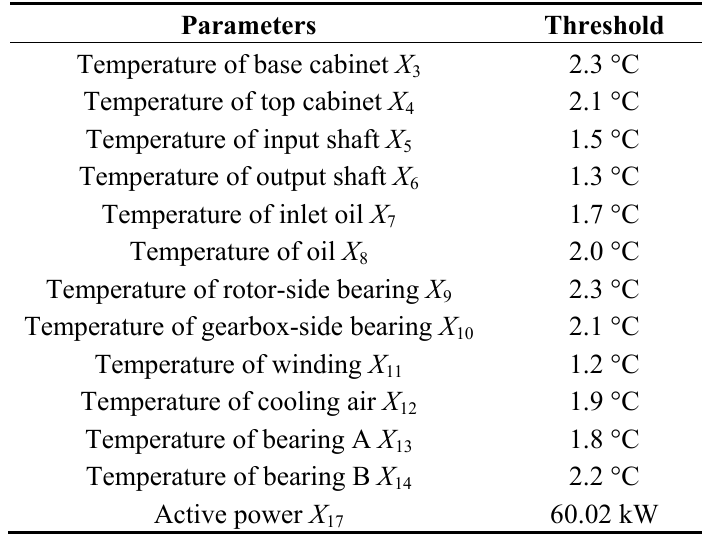
Table 3. Thresholds of the modeled